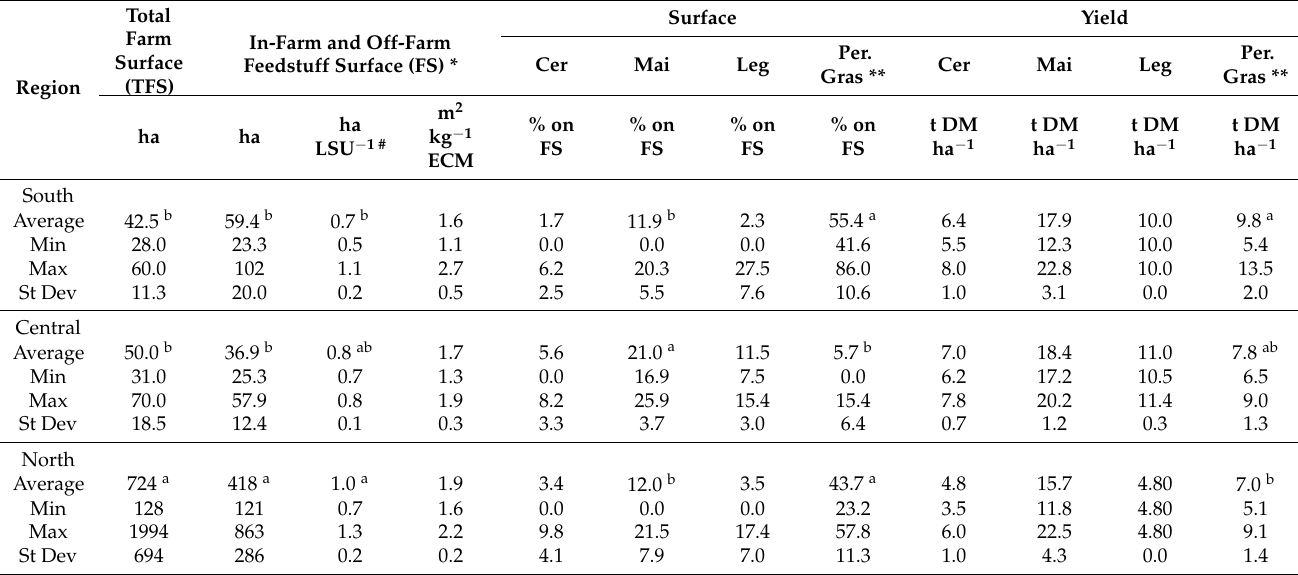
Table 6. Analysed farm data: surfaces and crop